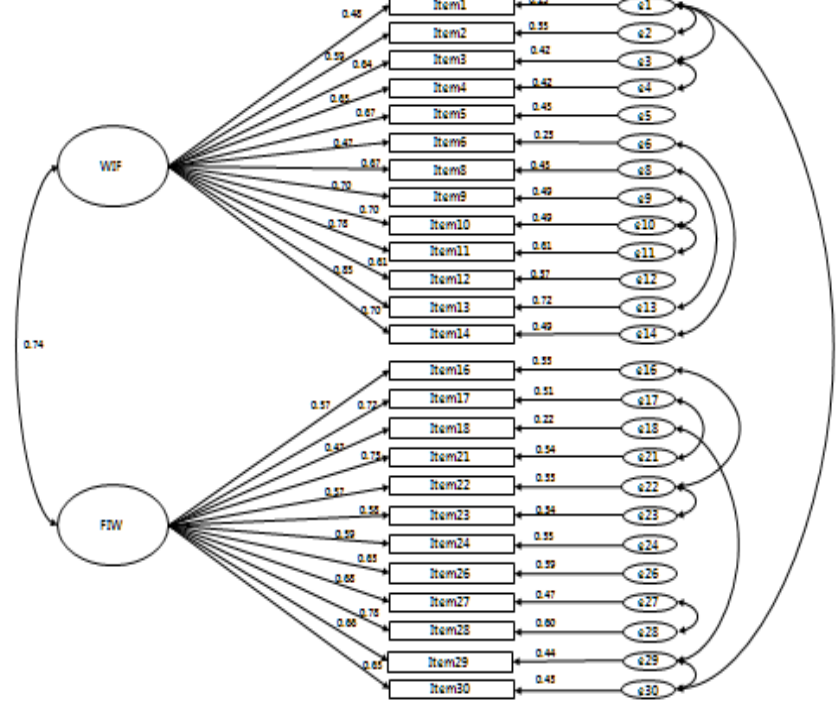
Figure 1. Confirmatory factor analysis.